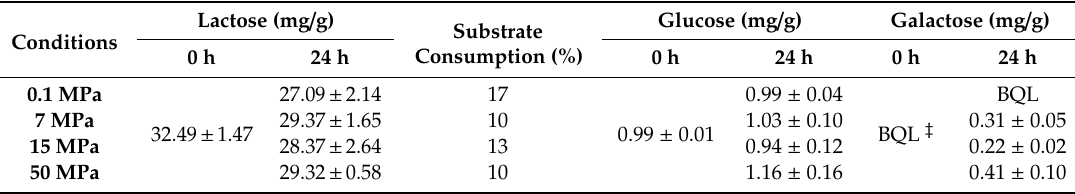
Table 4. Lactose, glucose, and galactose concentration quantified by HPLC analysis during fermentation under di ff erent pressure conditions (0.1, 15, and 50 MPa) at 17 ◦ C (the analysis was carried out at the beginning and the end of the